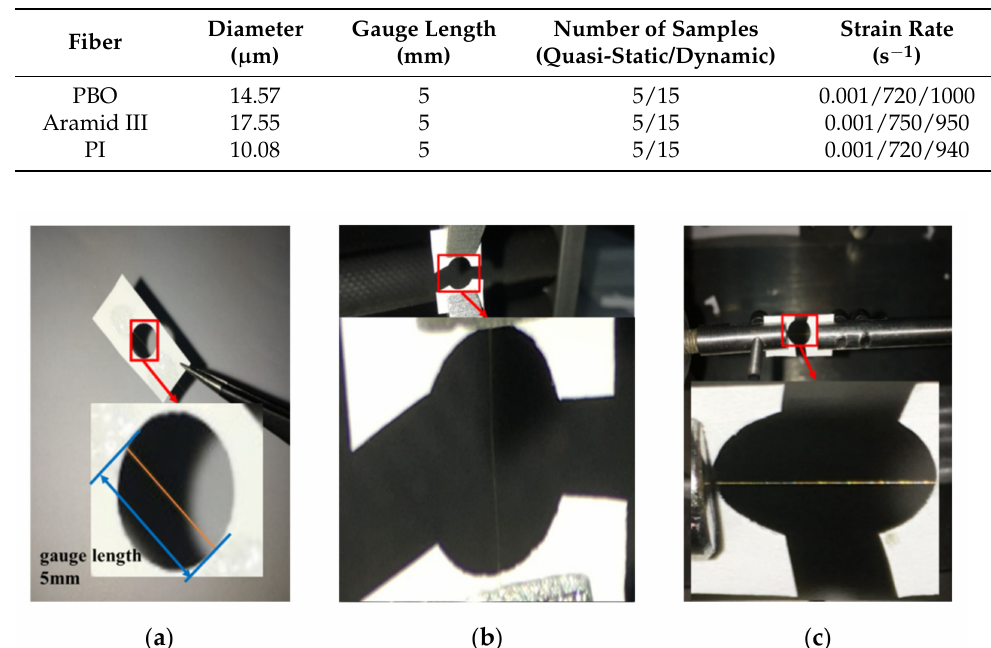
Figure 3. ( a ) Sample shape; ( b ) quasi-static tensile clamping; ( c ) dynamic tensile